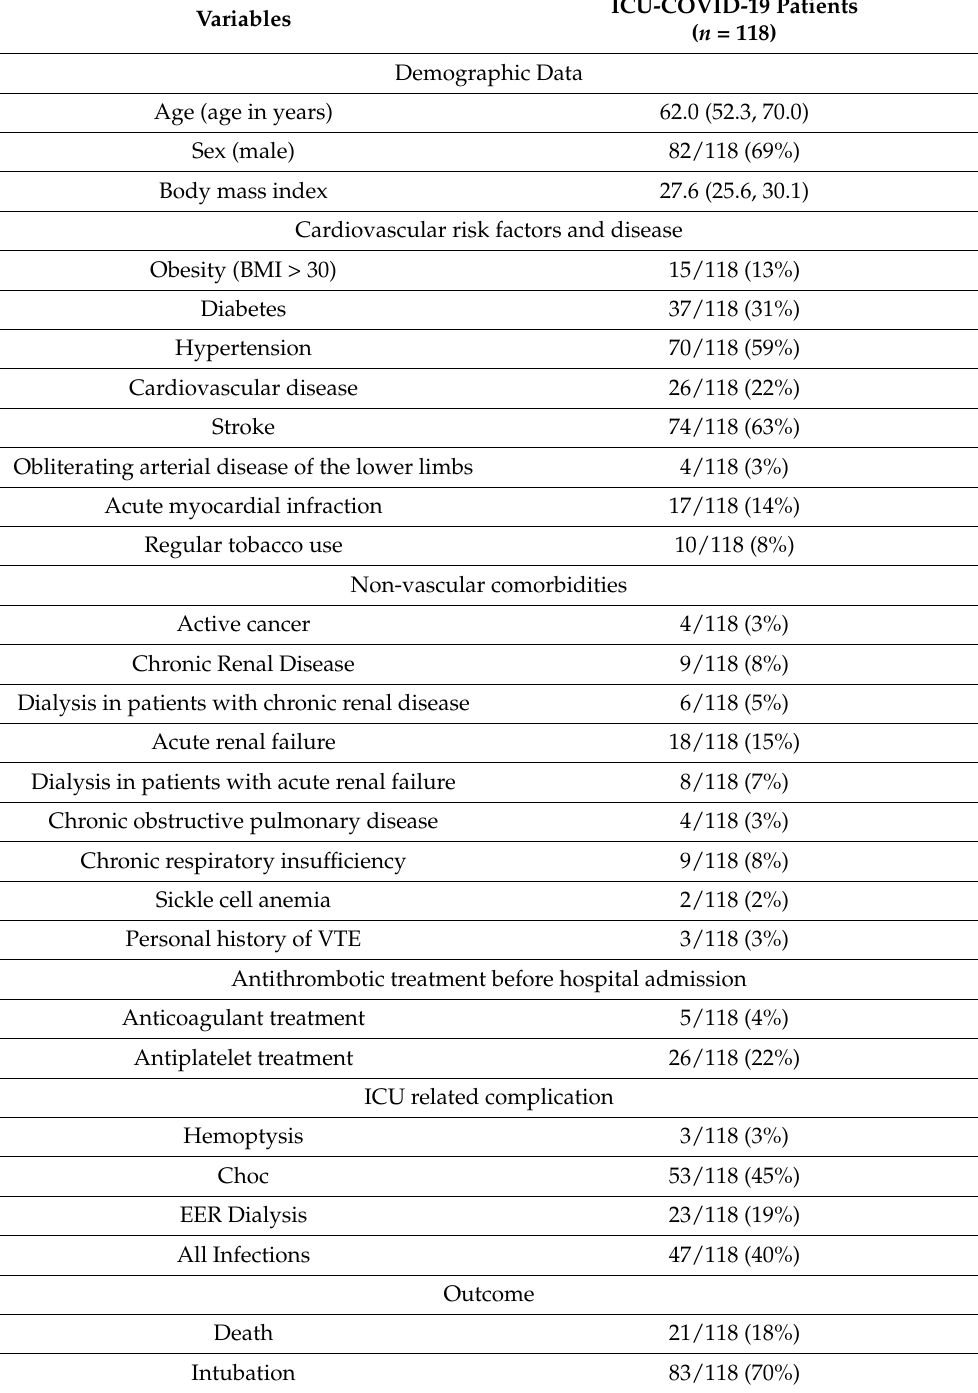
Table 1. Demographic and clinical data from patients with COVID-19 admitted in